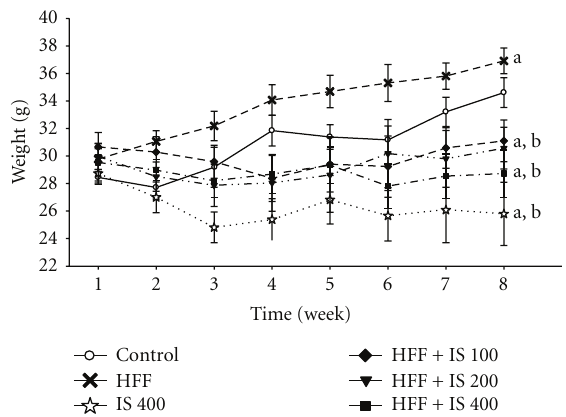
Figure 1: Body weight of mice fed a high-fat diet plus fructose (HFF) and treated with I. sonorae (IS) for 8 weeks; a: significant di ff erence compared to control; b: significant di ff erence compared to HFF, P < 0 . 001 (one-way ANOVA, Holm-Sidak post hoc test, n = 10 per